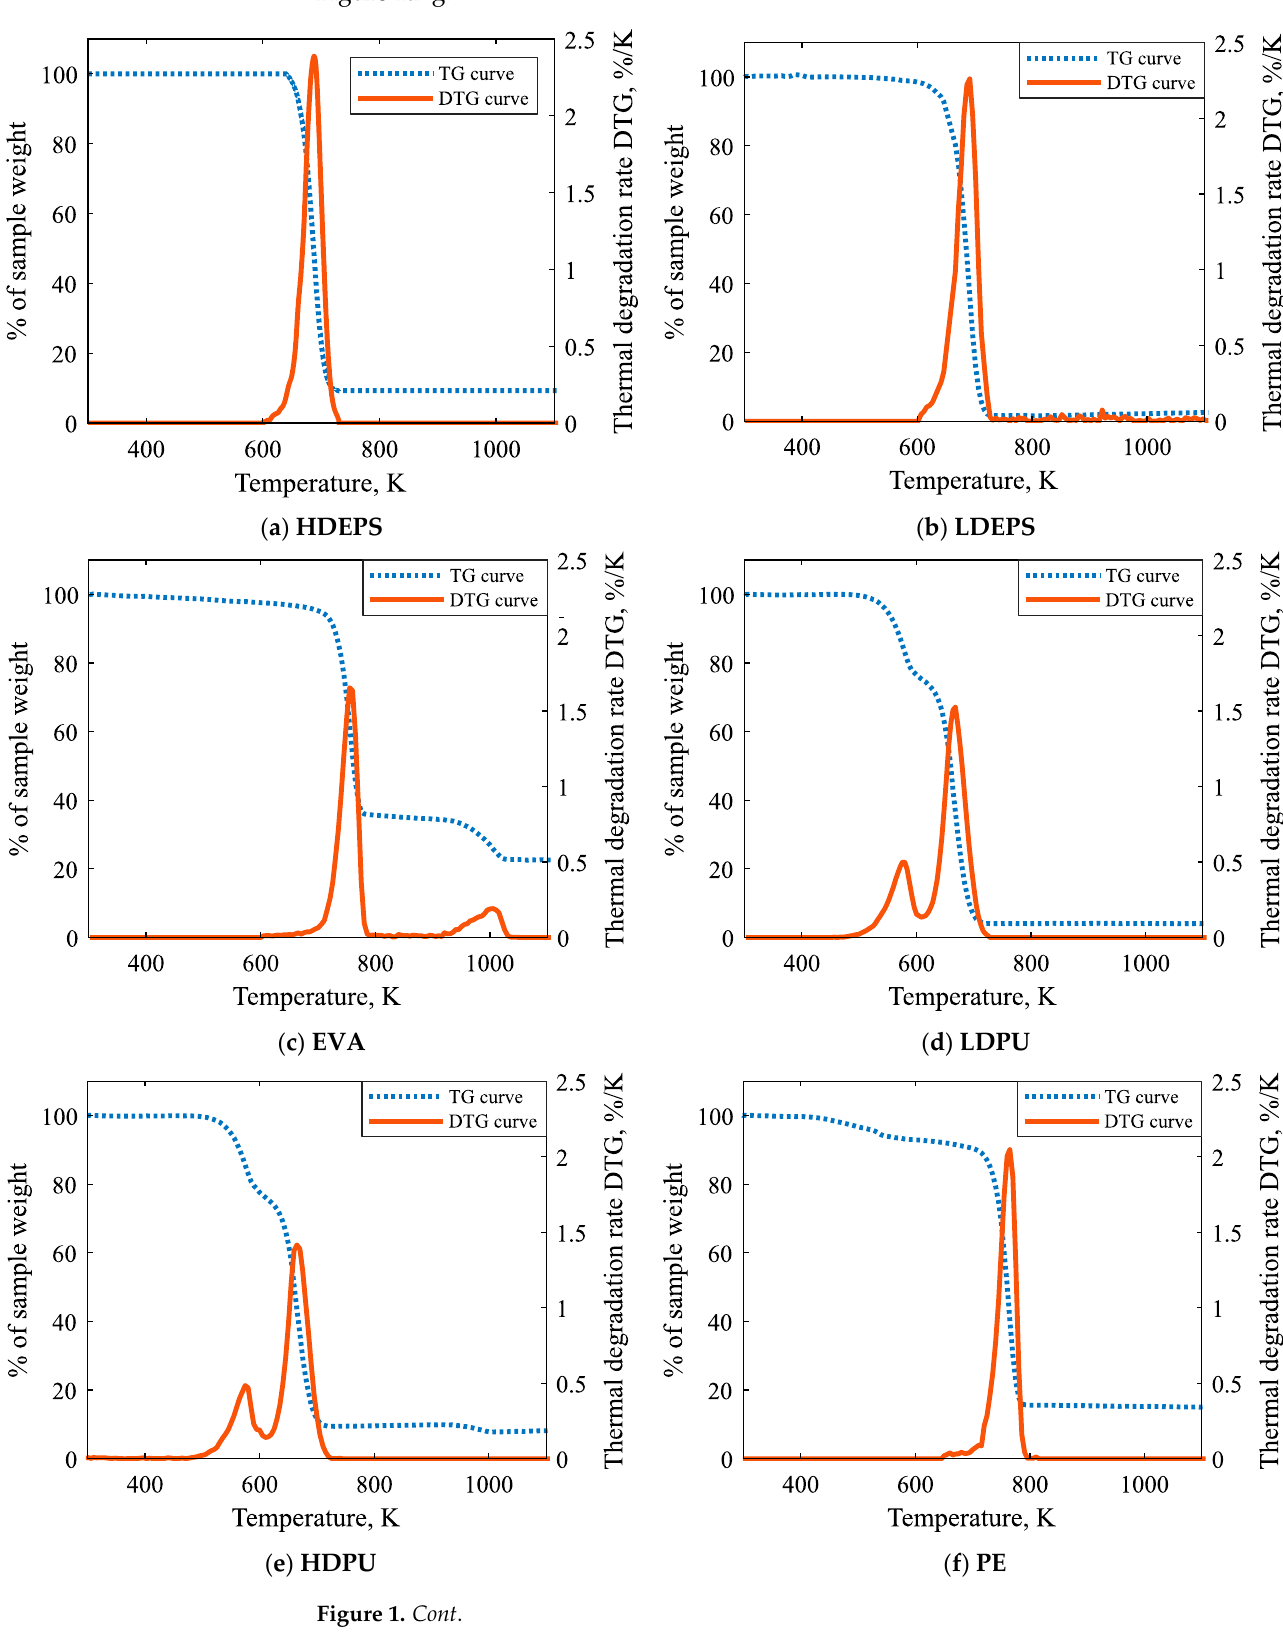
( g ) XPS Figure 1. TG and DTG curves of polymer samples at 20 K/min heating rate: ( a ) HDEPS; ( b ) LDEPS; ( c ) EVA; ( d ) LDPU; ( e ) HDPU; ( f ) PE; ( g ) XPS. The TG curve illustrates the change in mass with increasing temperature during the thermal decomposition process while the DTG curve, which is derived from the TG curve, shows the mass loss rate with increasing temperature or time. The temperatures at which the polymers undergo various stages of degradation, as well as the residual weight, are summarised in Table 3. The temperature at which the test samples lose 5% of their initial weight, denoted by T 5 %, signifies the onset of thermal degradation. PE underwent the earliest degradation at 520.3 K (T 5 %) while HDEPS exhibited the highest inertia towards initial degradation at 665.3 K (T5%). EVA, LDPU, and HDPU exhibited two stages of deg- radation with peak temperatures denoted by T max1 (major peak) and T max2 (minor peak), suggesting two stages of pyrolysis reactions, while PE, XPS, LDEPS, and HDEPS under- went only one stage of decomposition denoted by peak temperature T max1 . Both LDPU and HDPU demonstrated the least thermal stability with the lowest peak temperatures at 667.9 K (T max1 ) and 587.9 K(T max2 ) for LDPU and 665.1 K (T max1 ) and 574.8 K(T max2 ) for HDPU. It can be seen from Figure 1d,e that, for both LDPU and HDPU, approximately 22% mass loss occurred in the first stage of degradation while much of the mass loss of about 65– 72% took place in the second stage of degradation. On the other hand, EVA exhibited the best thermal performance with the highest peak temperatures, 755.3 K (T max1 ) and 1005.61 K (T max2 ). Additionally, it can be seen from Figure 1c that, for EVA, most of the mass loss of approximately 60% took place in the first stage of degradation while a minor mass loss